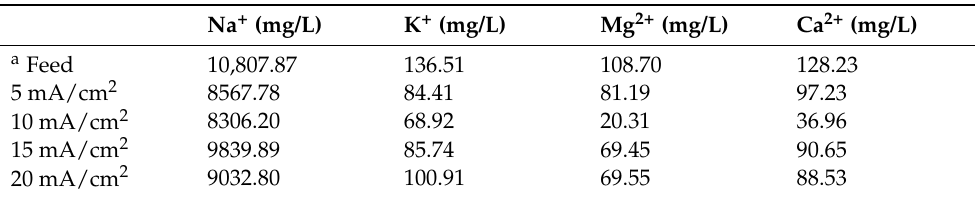
Table 6. The main components of the feed solution and the concentrated solution after SED at different current densities.